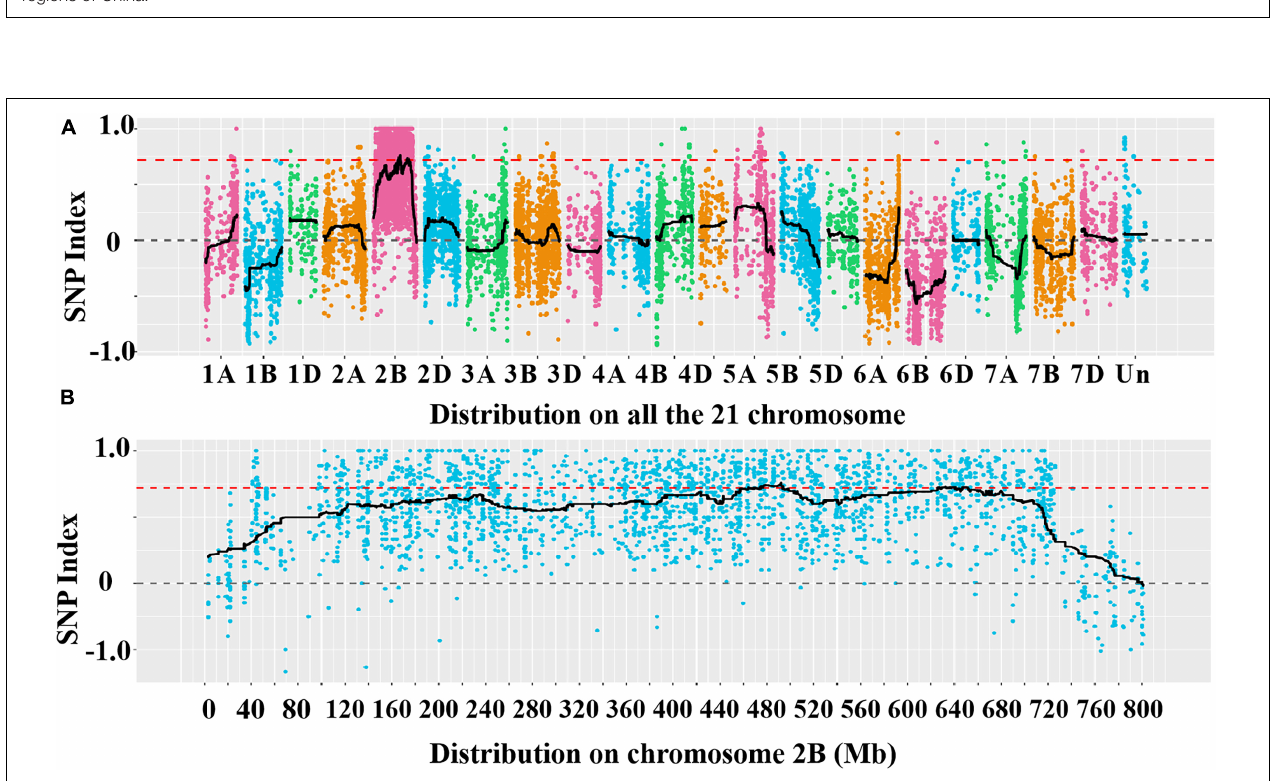
FIGURE 2 | Distribution of the single nucleotide polymorphisms (SNPs) with consistent differences between the resistant parent YD588 and susceptible parent Yannong 21 (YN21) and their derived bulked pools on 21 chromosomes (A) and on chromosome arm 2B (B) based on the (cid:49) SNP index value.